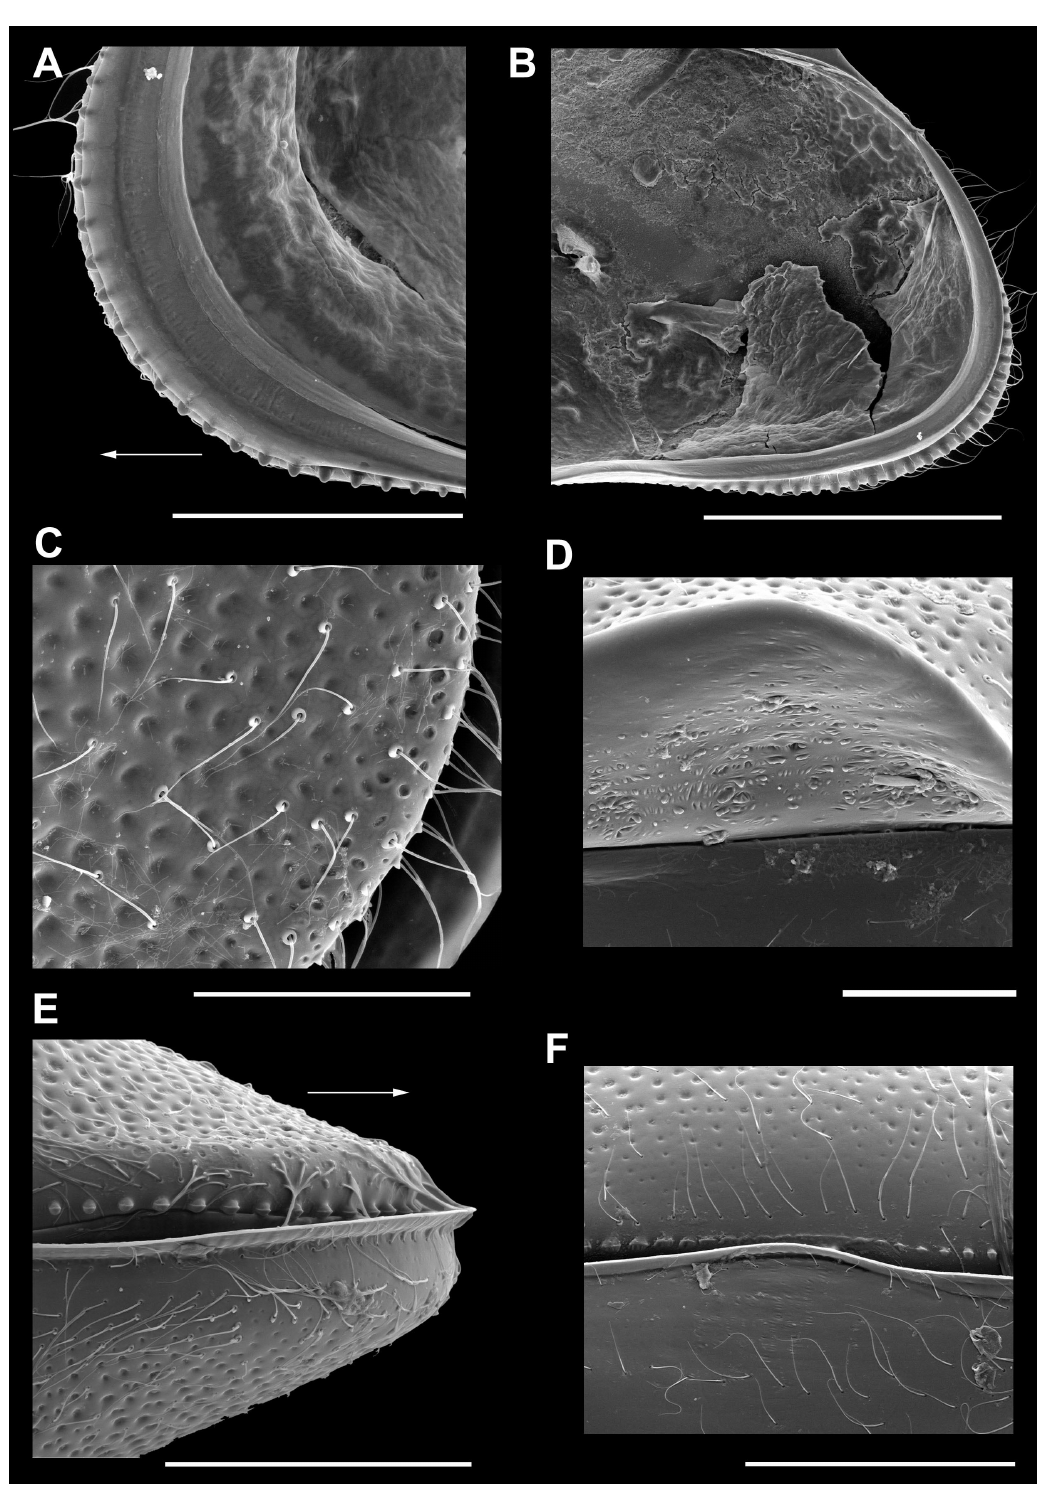
Fig. 3. Scanning Electron Microscope images of Cyprinotus drubea sp. nov., ♀♀. A . RVi, detail of anterior part (MNHN-IU-2019-784). B . RVi, detail of posterior part (MNHN-IU-2019-784). C . CpRL, detail of carapace surface (MNHN-IU-2019-783). D . CpD, detail of hump (MNHN-IU-2019-782). E . CpV, detail of anterior part (RBINS-INV.156001/OC.3401). F . CpV, detail of central overlap (RBINS-INV.156001/ OC.3401). Arrows indicate anterior side. Scale bars: A, D–E = 200 µm; B = 400 µm; C, F = 100